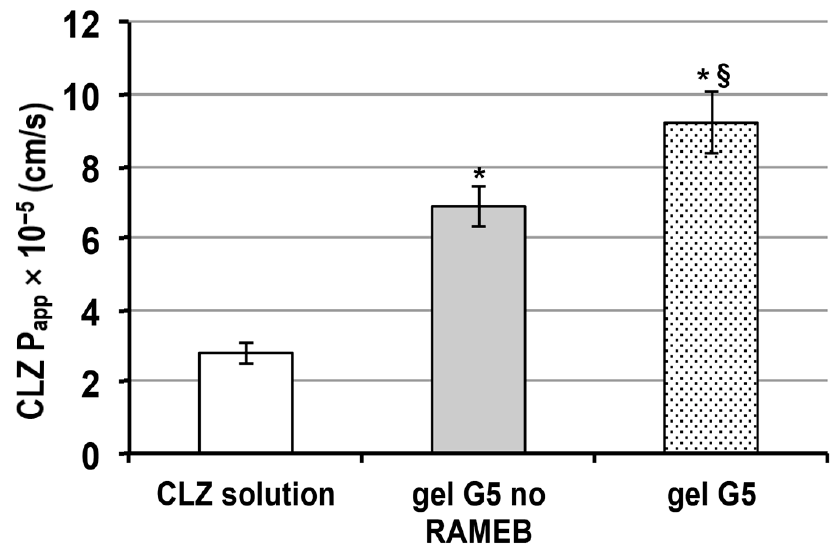
Figure 7. Apparent permeability coefficient (P app ) of clonazepam (CLZ) as solution, or as gel G5 formulation, in the absence or in the presence of RAMEB (see Table 2 for gel composition). * p < 0.01 vs. CLZ solution; § p < 0.05 vs G5 no RAMEB.